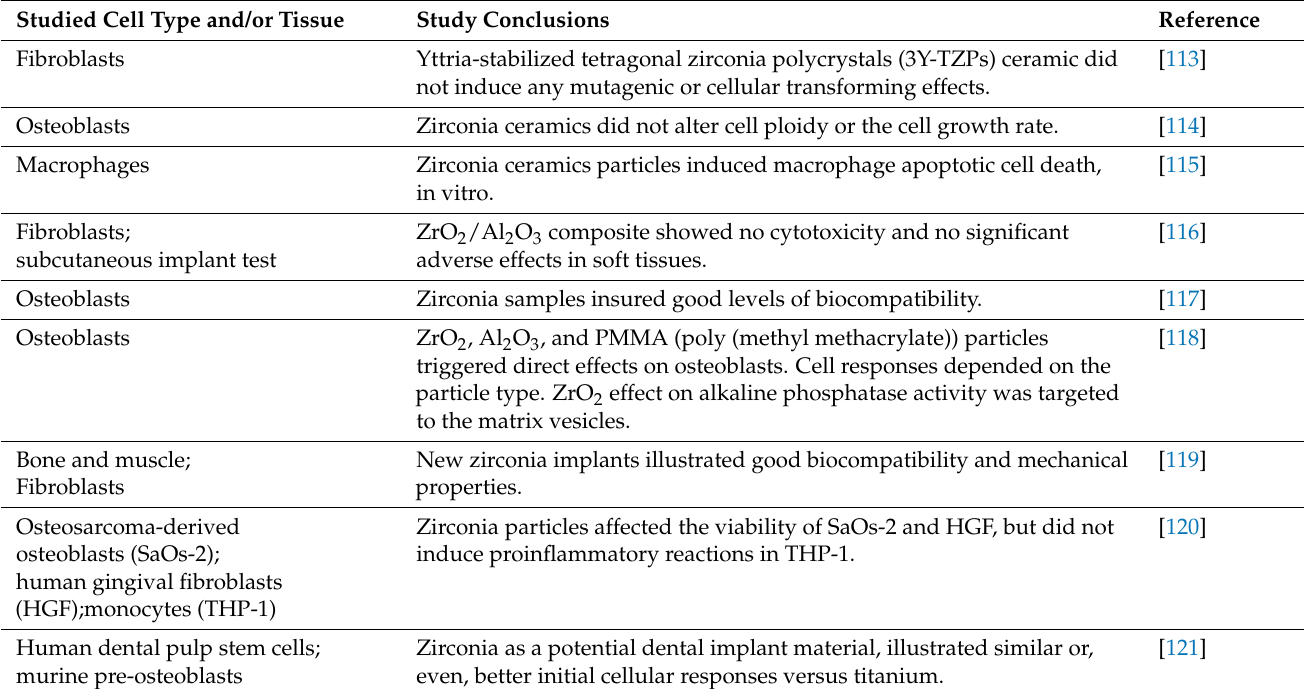
Table 1. Examples of in vitro and in vivo zirconia biocompatibility